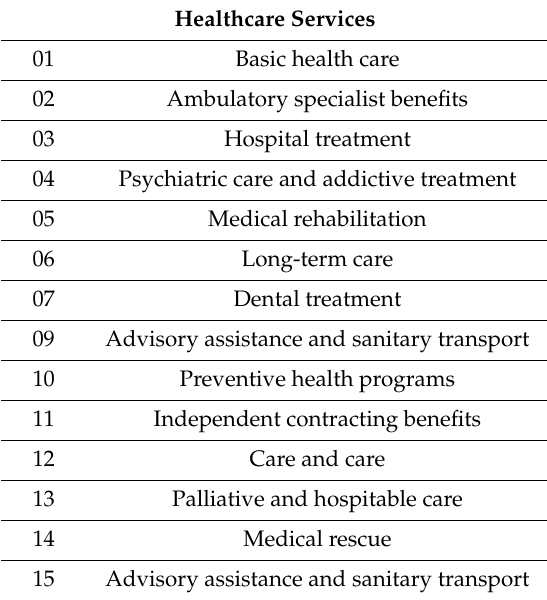
Table 1. Types of services covered by the National Health Fund (NHF) in